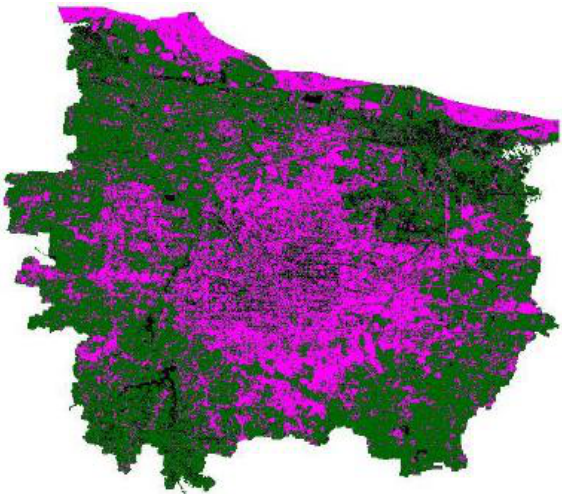
Fig. 4. Results of unsupervised classification of remote sensing images.